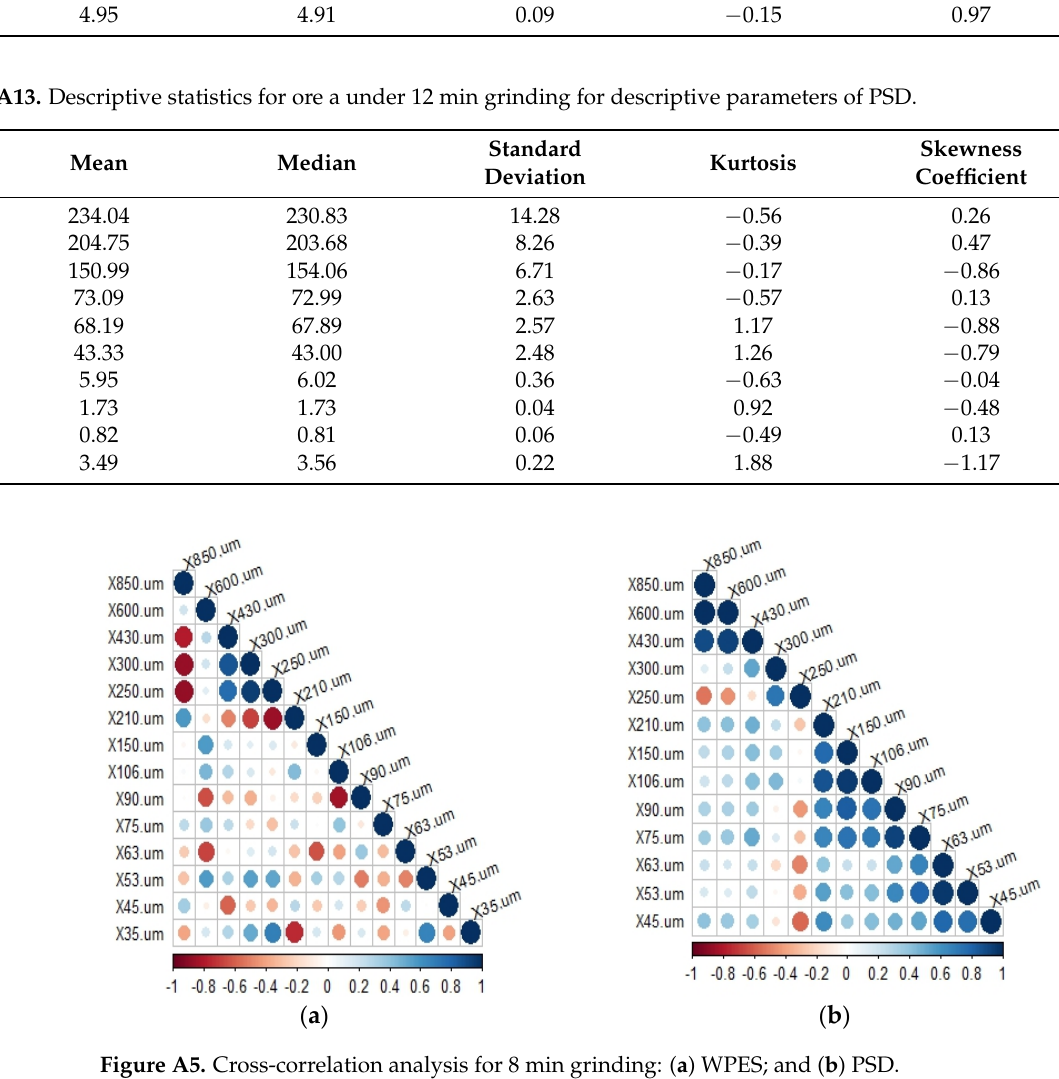
( a ) ( b ) Figure A6. Cross-correlation analysis for 12 min grinding; ( a ) WPES; and ( b ) PSD. References 1.